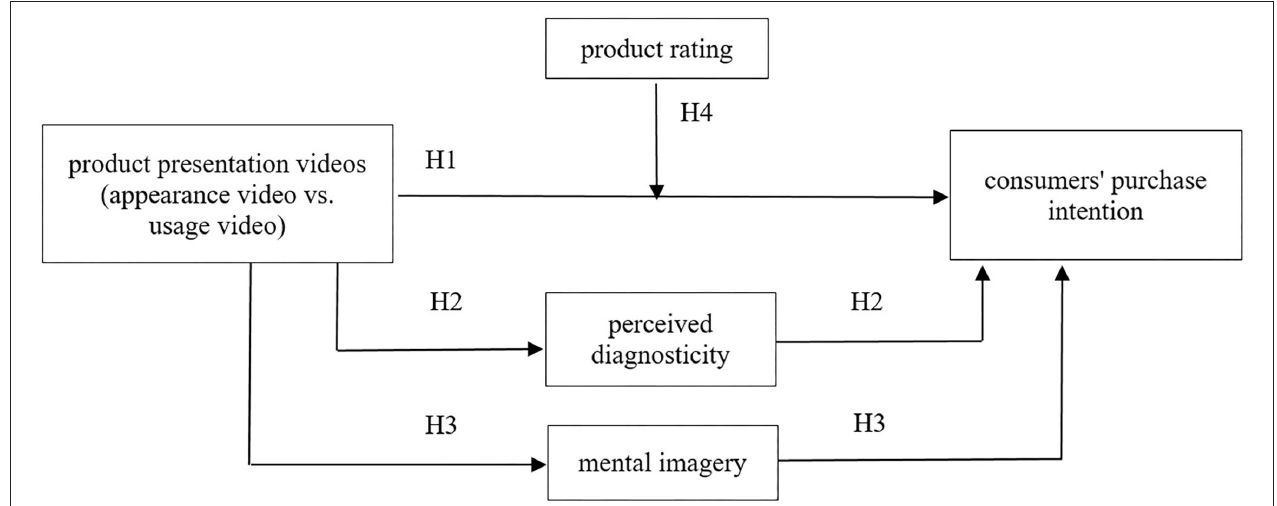
FIGURE 1 | A proposed research